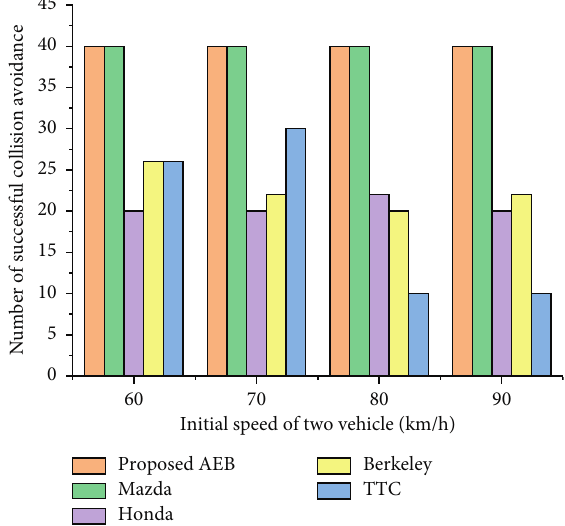
Figure 10: Comparison of the number of successful avoidance collisions between the